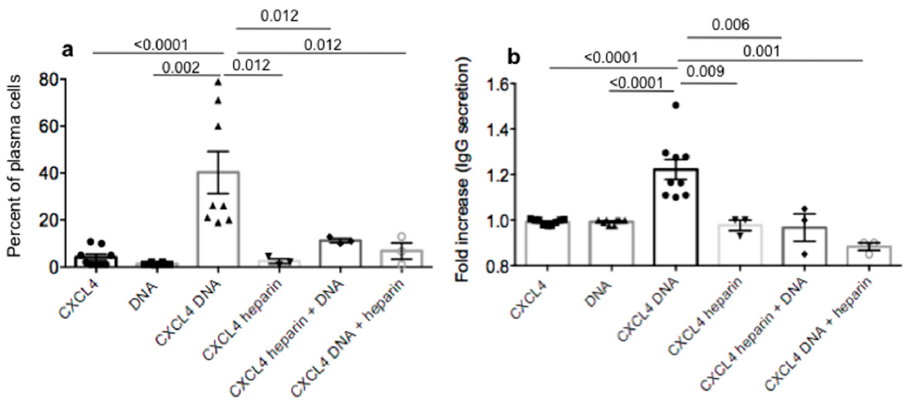
Figure 4. CXCL4–DNA complexes favor differentiation of antibody secreting plasma cells. B-cells isolated from HD were treated for 7 days as indicated (see Materials and Methods) and at the end of